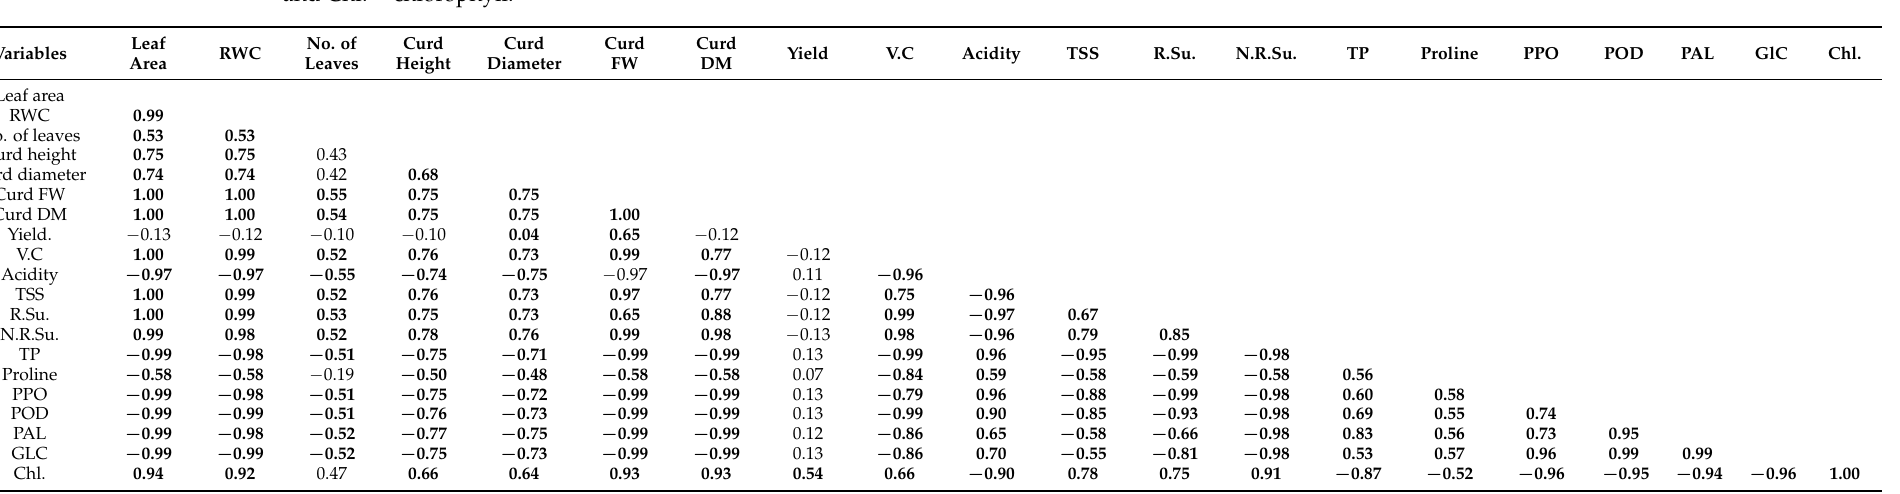
Table 3. Pearson’s correlation analysis among agro-physiological characteristics of the cauliflower plant sprayed with melatonin either under well-watered or water-stressed conditions. Values in bold are different from 0 with a significance level alpha = 0.05. RWC = relative water content, V.C = Vitamin C, TSS = total soluble sugar, Rsu = reducing sugar, TP = total phenol, PPO = polyphenol oxidase, POD = peroxidase, PAL = phenylalanine ammonia-lyase, GLC = glucosinolates, and Chl. =